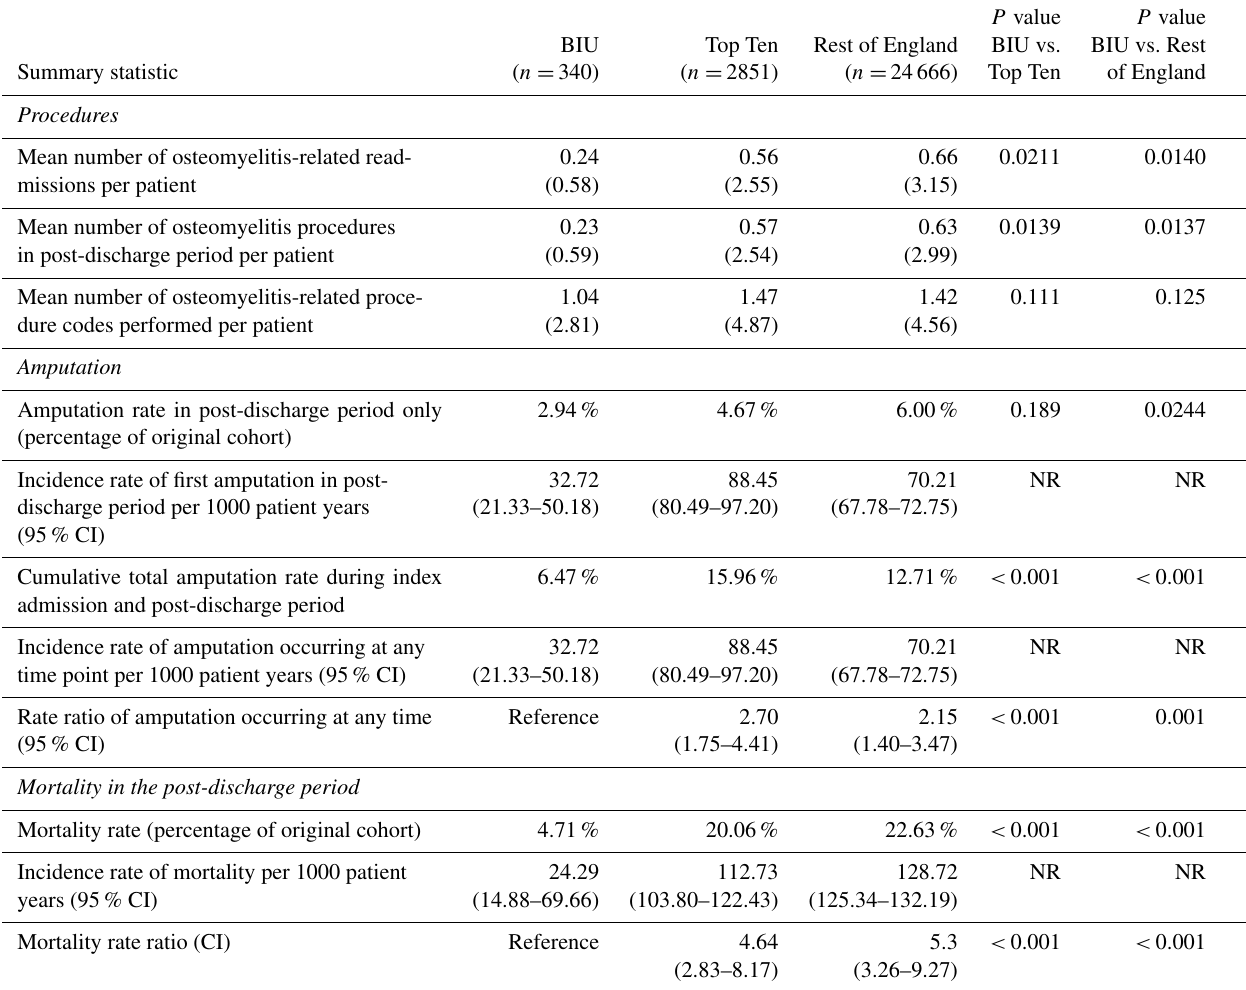
Table 3. Clinical outcomes during the 24-month post-discharge period following discharge from the index admission. Mortality and cumu- lative amputation rates are expressed from the day of the index procedure. Figures represent mean and (standard deviation) unless otherwise